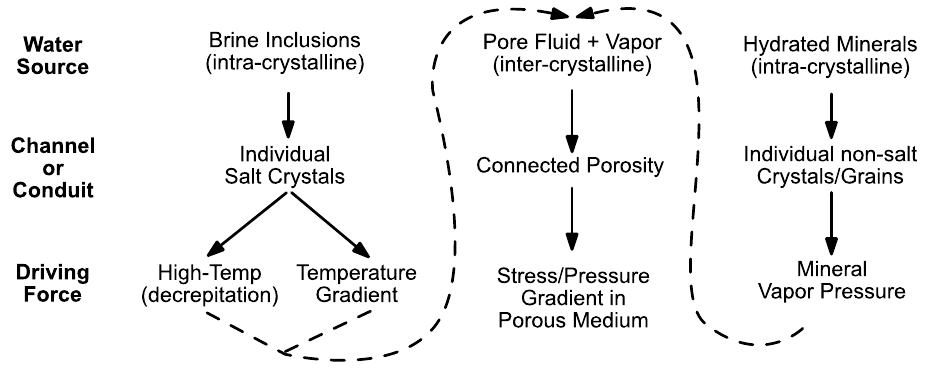
Figure 2. Brine types and flow mechanisms in salt (modified from Shefelbine